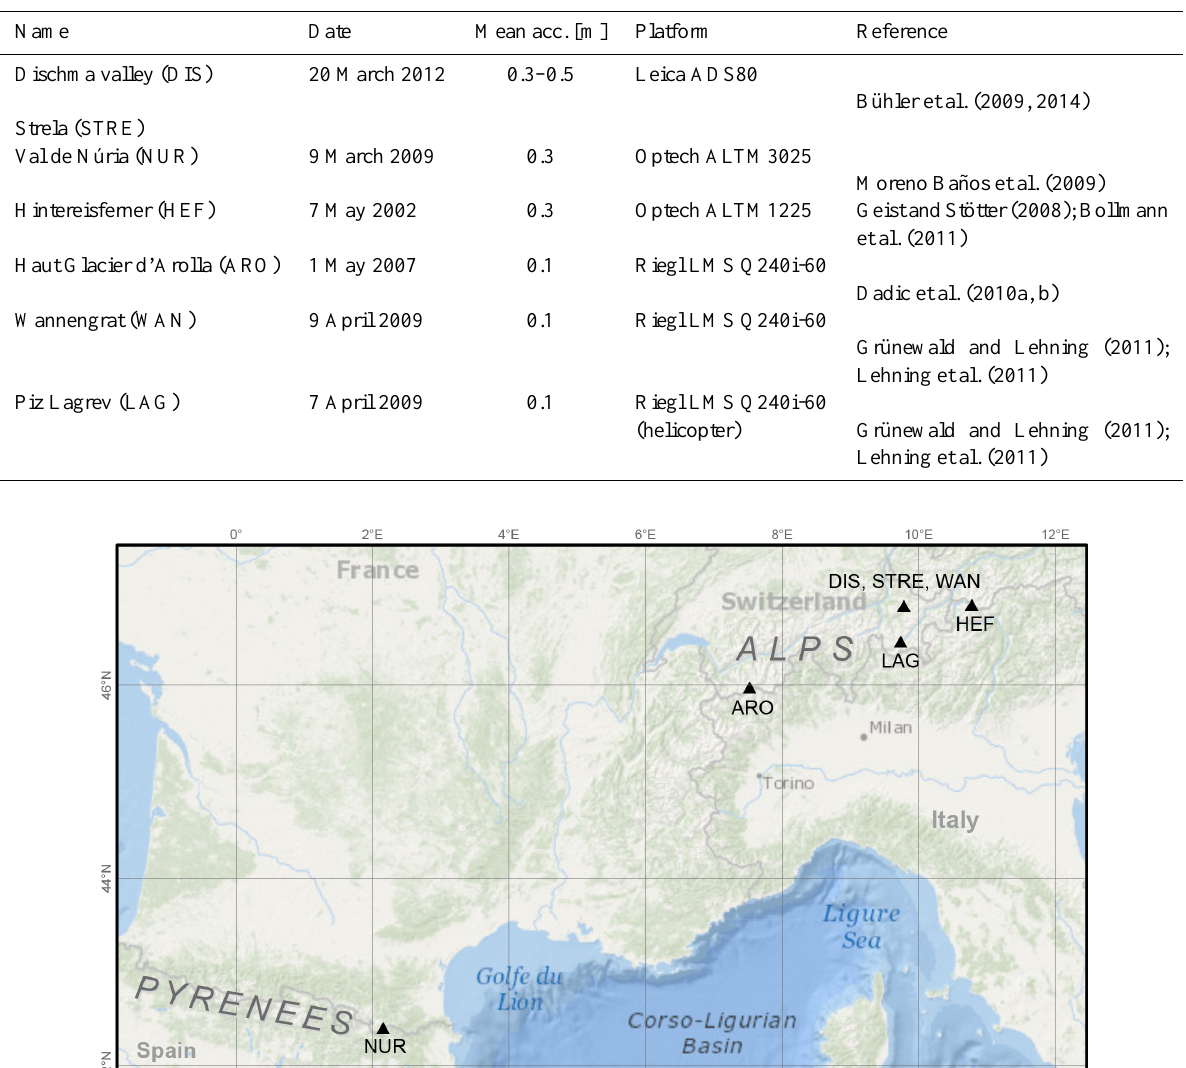
Figure 1. Location of the study sites Val de Núria (NUR), Haut Glacier d’Arolla (ARO), Dischma valley (DIS), Strela (STRE), Wan- nengrat (WAN), Hintereisferner (HEF) and Piz Lagrev (LAG). Basemap: Esri, GEBCO, NOAA, National Geographic, DeLorme, HERE, Geonames.org, and other contributors, reproduced with permission of